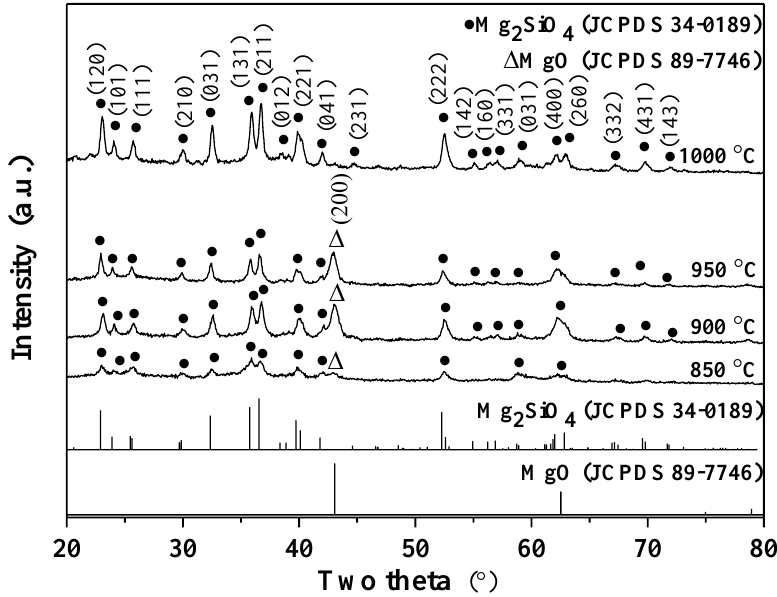
Figure 1. XRD patterns of Mg 2 SiO 4 -calcined powders at temperatures of 850, 900, 950, and 1000 °C.